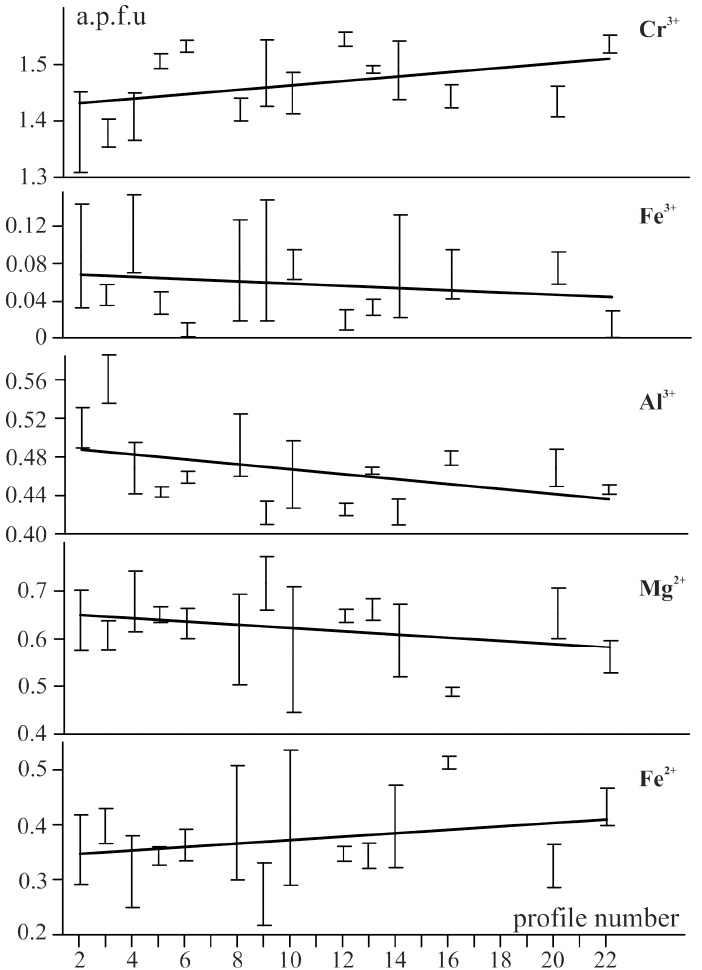
Figure 6. Relationship between the lateral zoning of the ore deposit and Cr-spinel composition. Designations of the profile numbers are shown in Figure 4.